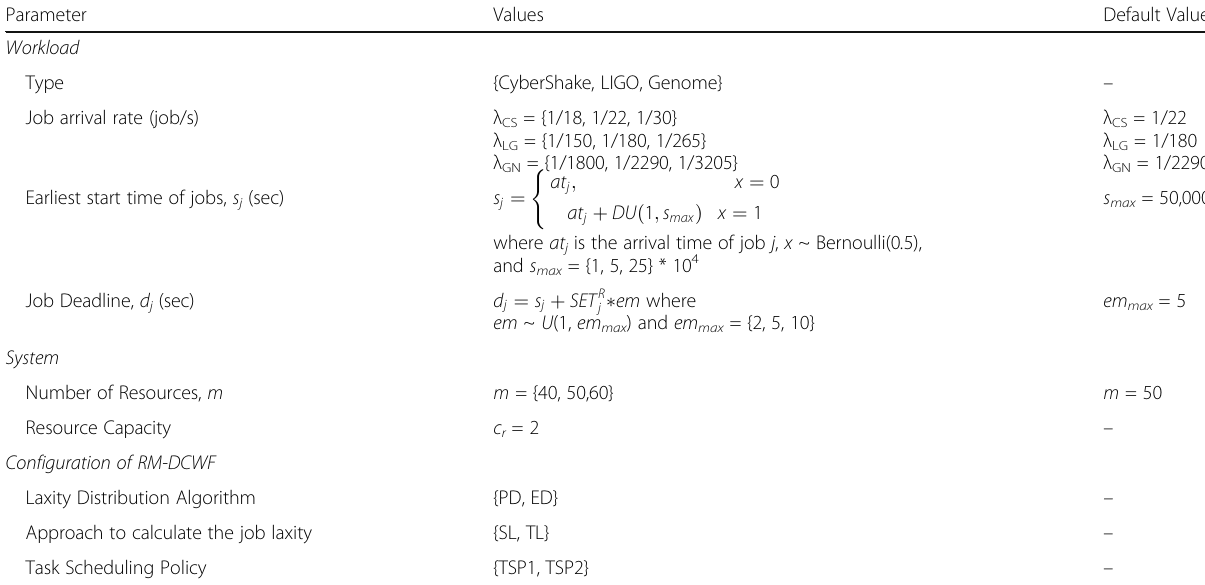
Table 1 System and Workload Parameters for the Factor-at-a-Time Experiments